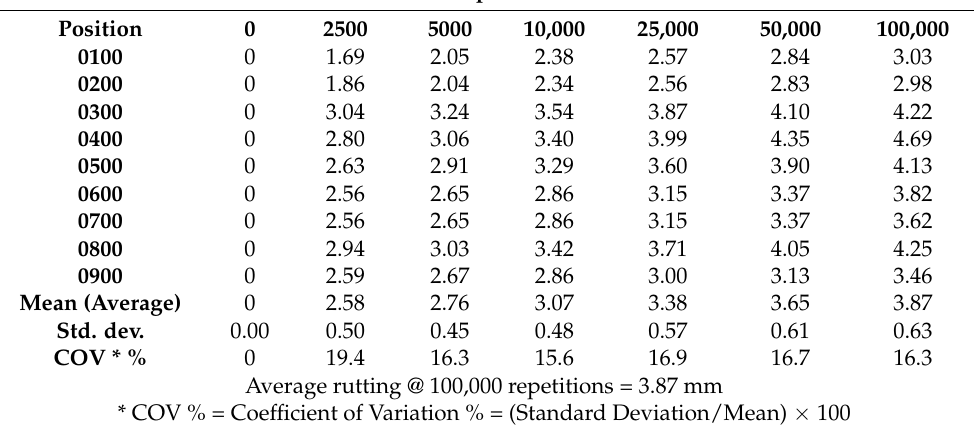
Table 5. Summary of the rut depth measurements at various positions and repetitions of the stand-